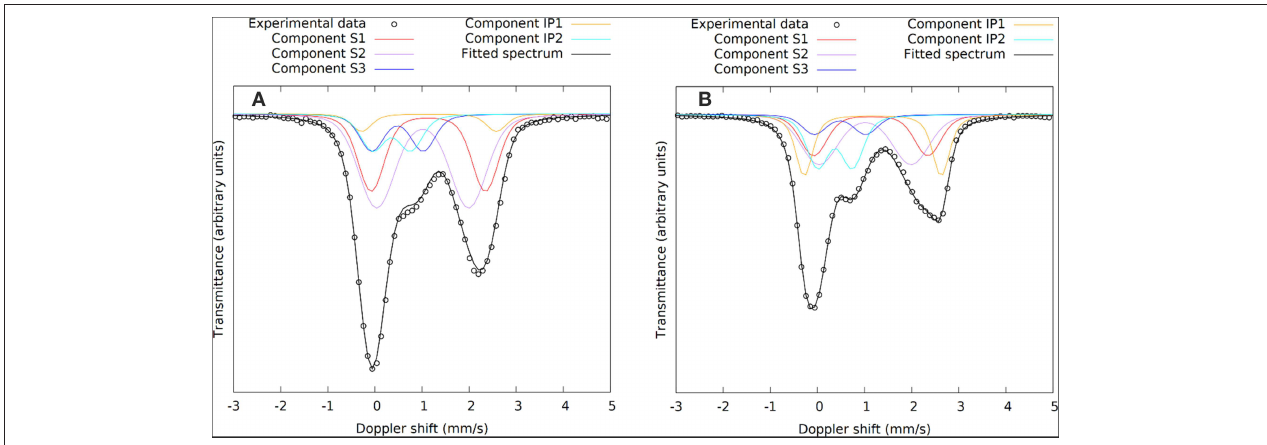
FIGURE 4 | 57 Fe Mössbauer spectra of the IPs recorded at (A) 1 day and (B) 28 days. The slag components (S1, S2, S3) are shown in the same colors as Figure 3 and the binder components (IP1, IP2) are added in yellow and